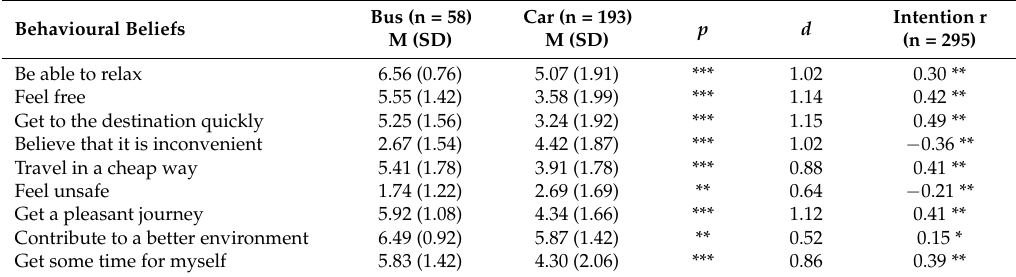
Table 5. Behavioural beliefs for a journey by bus. Mean, SDs, Cohen’s d for either bus users or car drivers and Pearson’s correlation with intention to use the bus.